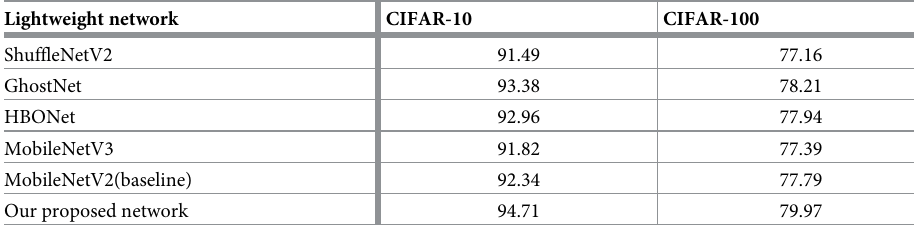
Table 9. TOP-1 accuracies on CIFAR100 and CIFAR10